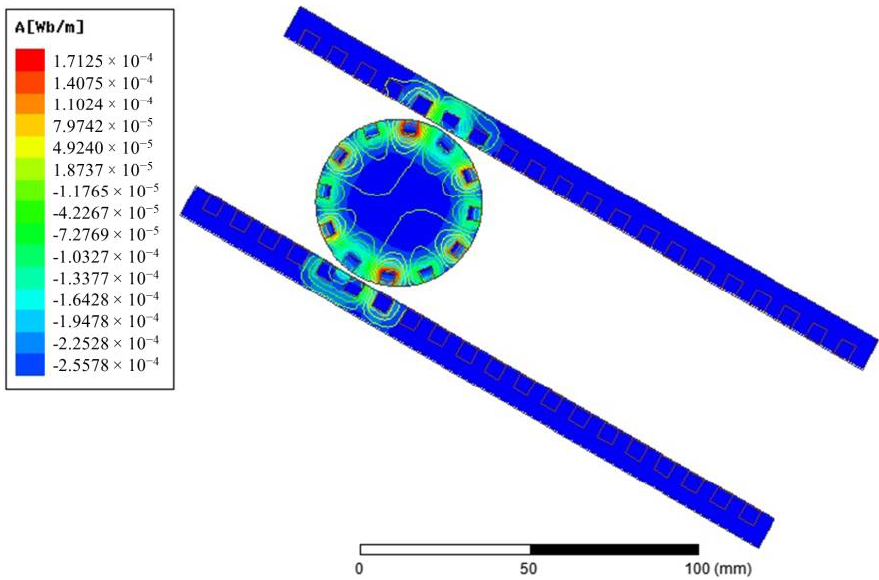
Figure 12. Flux lines due to an excited rotor.